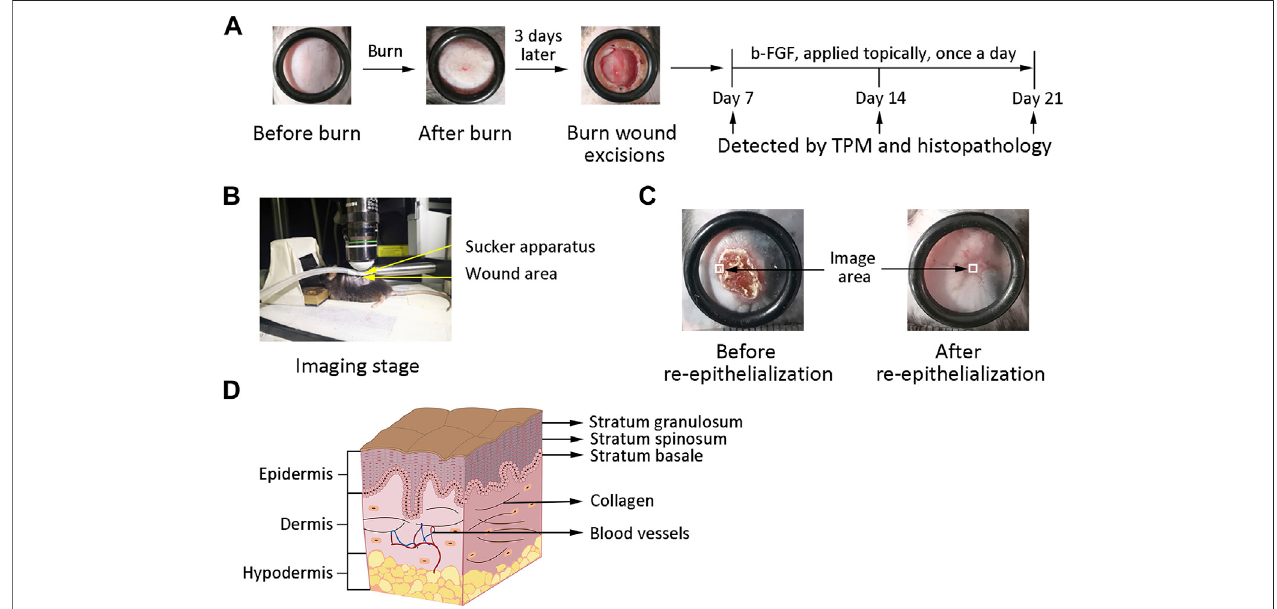
FIGURE 1 | Experimental scheme and schematic illustration of the skin. (A) Establishment of the deep-burn model and experimental scheme. (B) Anesthetized mouse on theimagingstage. Yellow arrows point at thesuckerapparatusand woundarea. (C) Imagingareaat themargin before re-epithelializationand at thecenterof wound after re-epithelialization. The white square represents the imaging area. (D) Schematic illustration of the skin. Black arrows point at the different compositions of the skin.